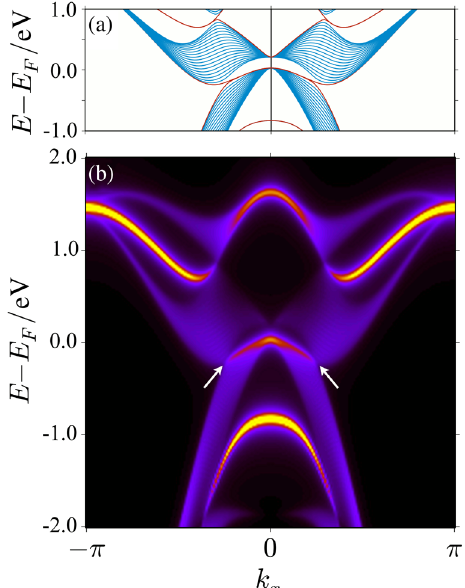
FIG. 7. (a) Band structure of a screw-symmetric ribbon of WTe 2 calculated using the tight-binding model discussed in Sec. IVA. The ribbon is periodic in e , and is 20-unit-cell wide in x e . The edge states are highlighted in red. (b) Spectral function of y the slab projected onto the first unit cell of the edge. Bright colors indicate a large contribution from the atoms located at the edge. The arrows indicate the Dirac